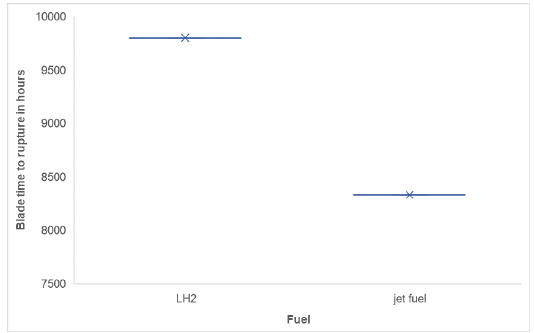
Figure 5. Creep life estimation.